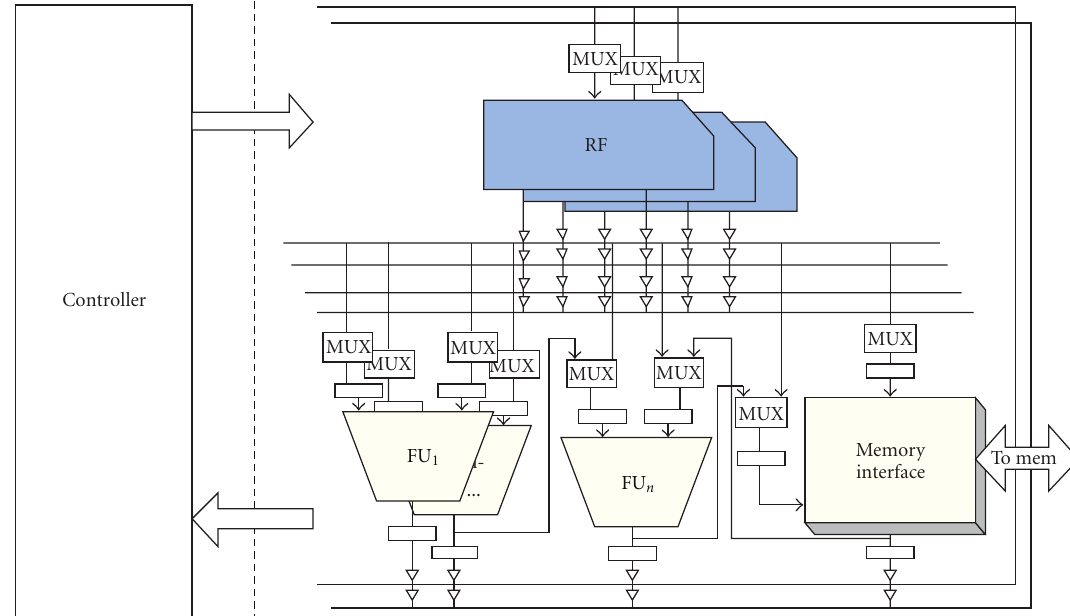
Figure 2: Proposed processor core template: the data path and the controller are created separately.